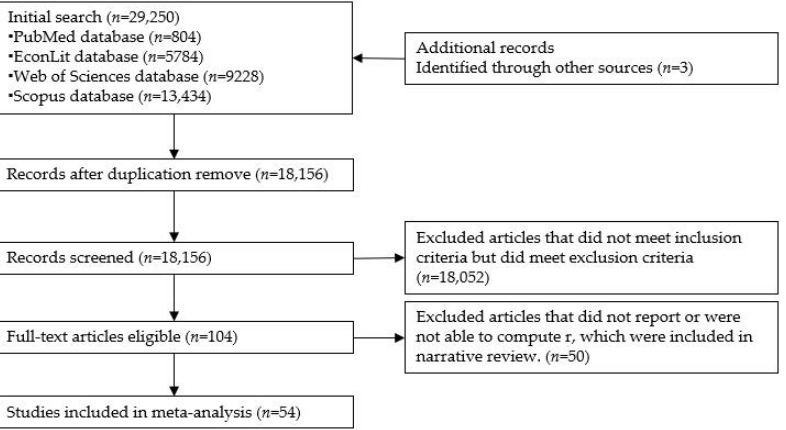
Figure 1. The search and selection process for identifying papers included in the meta-analysis.